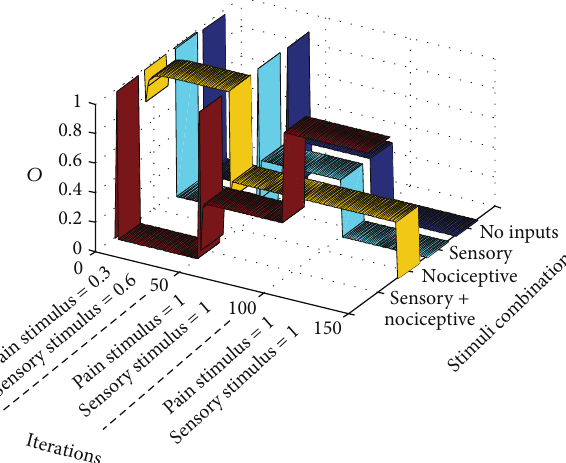
Figure14:Modellingthehypotheticalsituationwhere,afteraperiod of standard stimulation, gate circuit inputs are both very intense as from iteration 50 to iteration 100. After iteration 100, the four different combinations of nociceptive/sensory inputs are presented to the circuit. In the present case, as in Figures 10 and 11 cases, plasticity is blocked from iterations 100 to 150, in order to analyze the response of the circuit. As can be noticed, pain response is only intense when both sensory and nociceptive inputs are intense and are simultaneously applied. When only a nociceptive intense input is applied, the pain response is moderate. No pain response is obtained in the remaining